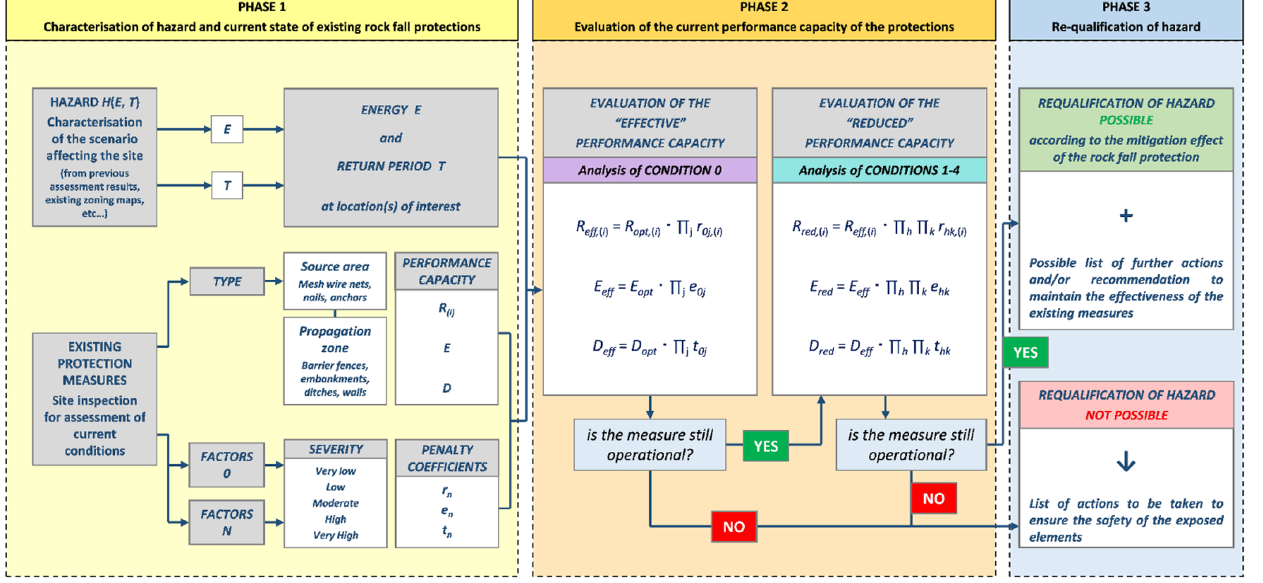
Table 1. List of factors potentially degrading the performance of rock fall protection measures— Group 0 (most/all types of protections) .